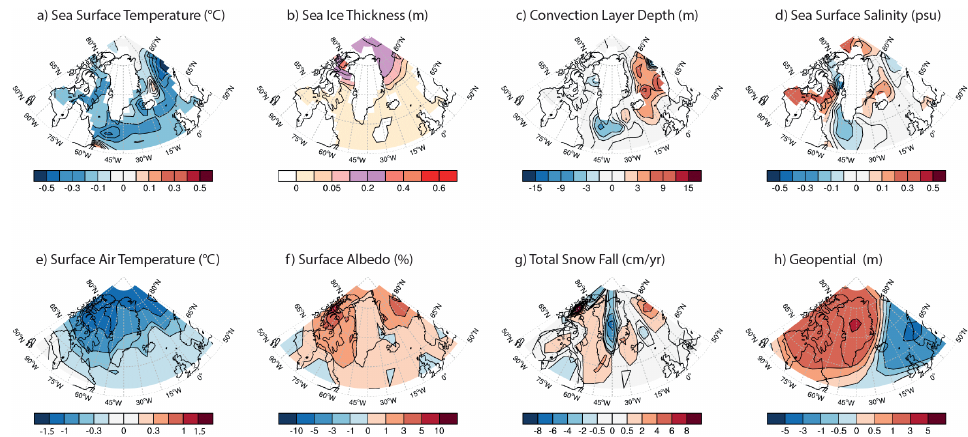
Figure 8. FWFf–CTRL differences of 1000-year averages: (a) sea surface temperature, SST ( ◦ C, non-linear colour scheme); (b) sea-ice thickness (m, non-linear colour scheme); (c) convection layer depth, CLD (m); (d) sea surface salinity, SSS (psu); (e) air temperature, TAIR ( ◦ C); (f) surface albedo, ALB (%, non-linear colour scheme); (g) total snowfall, SNOW (cmyr − 1 , non-linear colour scheme); (h) geopotential (m, non-linear colour